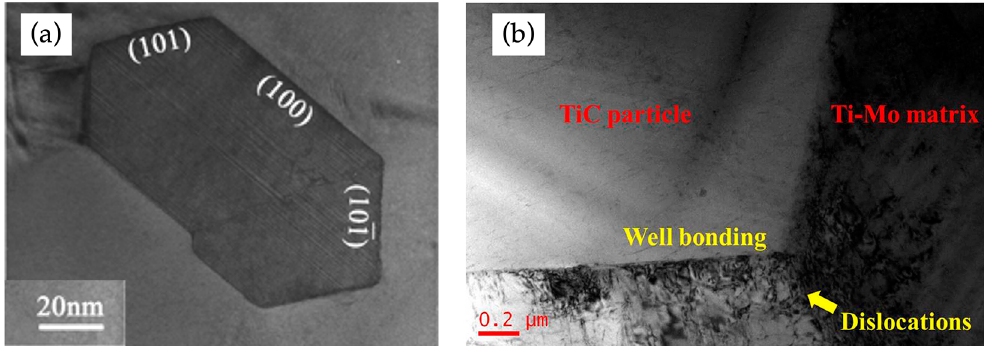
Figure 1. In situ composites produced by powder metallurgy. HDTEM images highlighting the interface between in situ ( a ) TiB and ( b ) TiC reinforcements and titanium matrices.